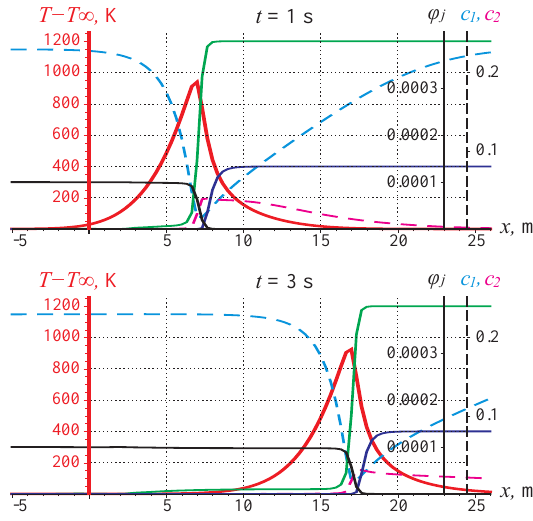
Figure 4. Typical profiles of forest fire characteristics at steady propagation scenario at moments of time t = 1 , 3 s. Let’s notice, that similar distributions ( u ∞ = 8 m/s, W = 66 . 66 %, ρ 0